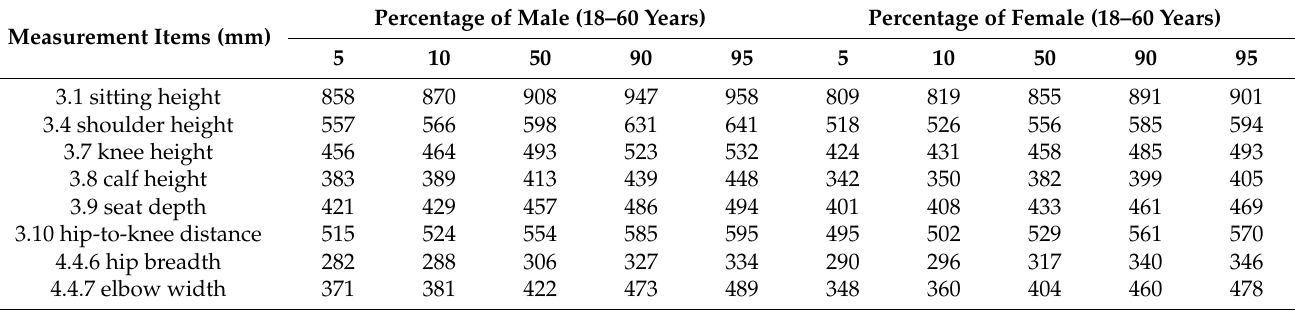
According to the human body size data, the final basic size parameters of the wheelchair are shown in Table 2.